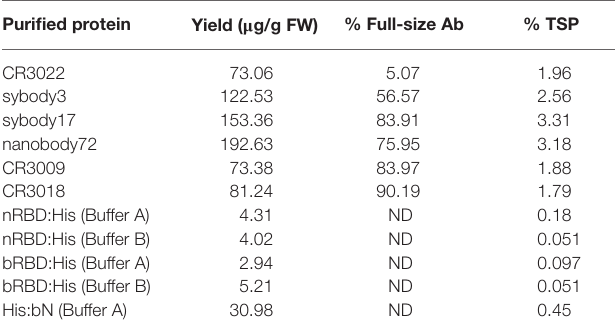
TABLE 2 | Yield estimation for all six purified recombinant antibodies, RBD and N proteins. Purified protein